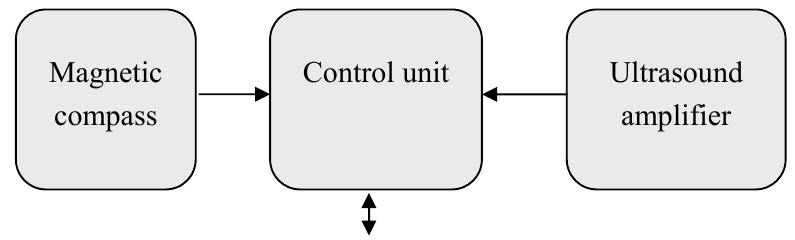
Figure 15 . Receiver block